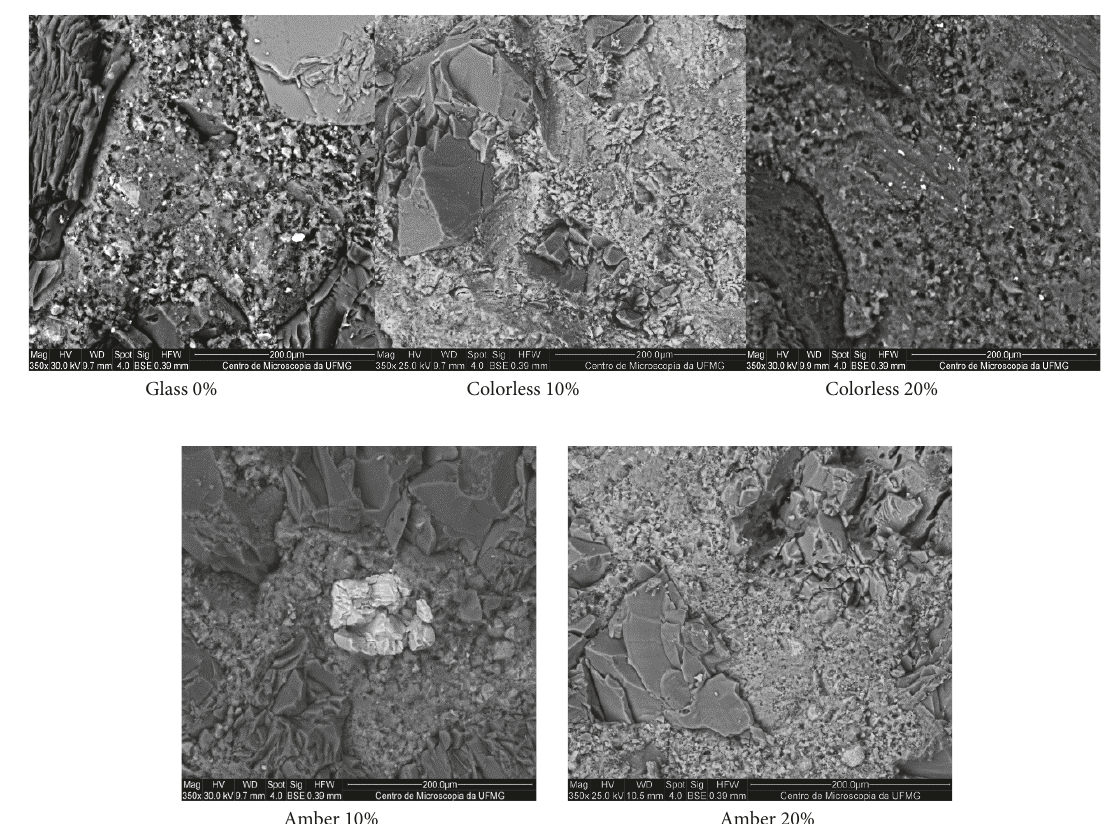
Figure 6: Images obtained by scanning electron microscopy (backscattered electrons) for samples with and without the replacement of glass